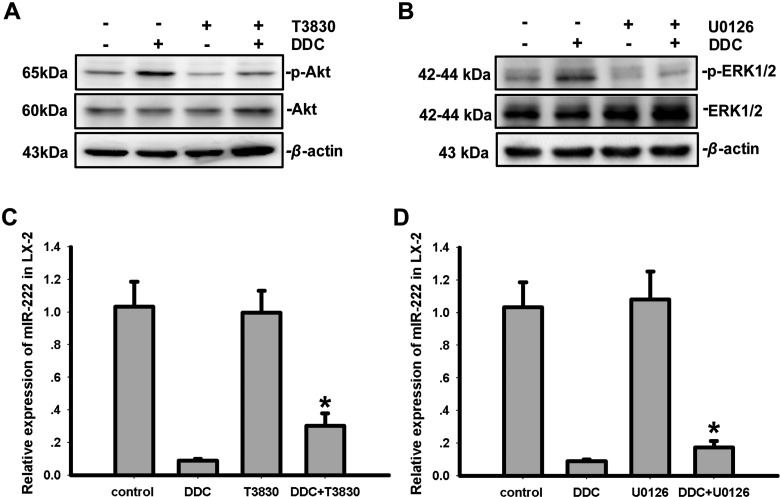
DDC inhibits the expression of miR-222 in LX-2 cells through Akt and ERK1/2 pathways(A) Co-cultures were treated with or without 100 μM DDC for 1 h in the presence or absence of an Akt inhibitor (T3830, 50 μM). The phosphorylation levels of Akt were analysed by Western blotting. (B) Co-cultures were treated with or without 100 μM DDC for 1 h in the presence or absence of an ERK1/2 inhibitor (U0126, 10 μM). The phosphorylation levels of ERK1/2 were analysed by Western blotting. (C) Co-cultures were treated with or without 100 μM DDC for 24 h in the presence or absence of an Akt inhibitor (T3830, 50 μM). The MMP-1 protein levels were analysed by Western blotting. (D) The co-cultures were treated with or without 100 μM DDC for 24 h in the presence or absence of an ERK1/2 inhibitor (U0126, 10 μM). The MMP-1 protein levels were analysed by Western blotting. These experiments were repeated at least three times. The results are represented as the mean±the S.D.s of three independent experiments. * P< 0.05 compared with LX-2/C3A treated by DDC.